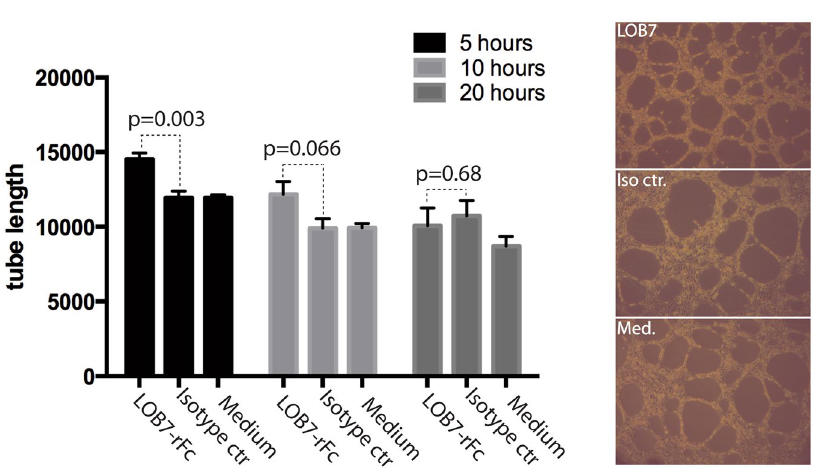
Figure 3. Tube formation using growth factor reduced matrigel in IBIDI angiogenesis slides. The tube length was measured as number of pixels using a MathWorks MatLab program. To the right, pictures are shown for 5 hours of incubation, from the top: LOB7, isotype control (anti HNE- α 7), and medium only. Error bars: Standard error of the mean